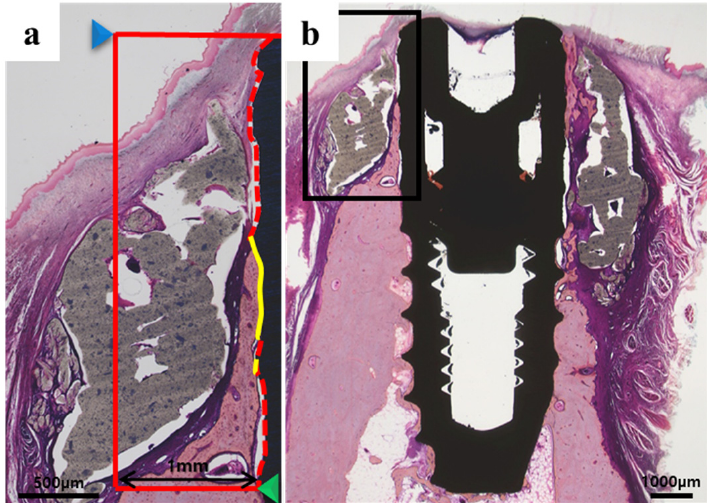
Figure 16. Bone-to-implant contact and new bone area in histologic specimens: ( a ) Red box, the area of interest (AOI is 1 mm wide and height from the new bone to the top of the implant (NB-I)); Blue arrow, top of implant; Green arrow, the bottom of new bone (NB); Yellow line, bone-to-implant contact (BIC).The following measurements were analyzed within the histologic specimens; ( b ) Representative histologic specimens.